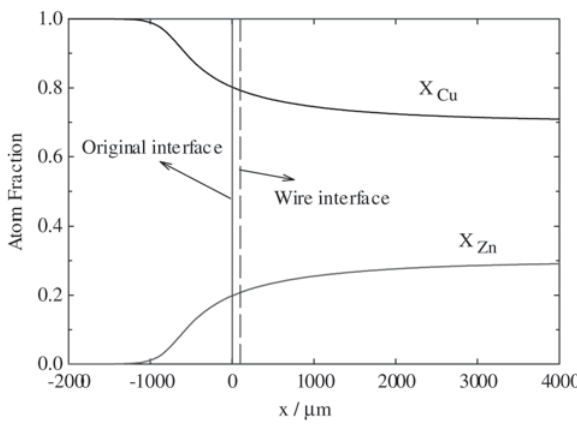
Figure 4. Displacement of wires in an interdiffusion experiment for the Cu-Zn system, a phenomenon known as the Kirkendall ef- fect 7